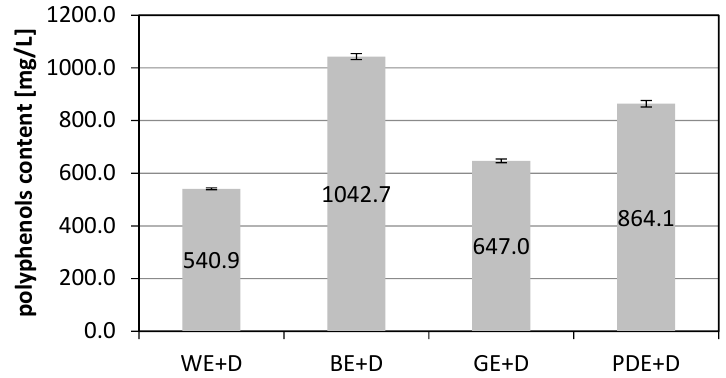
Figure 1. Total content of polyphenols expressed as mg of Gallic acid equivalents (GA) in 1 L of dogwood extracts (WE+D—water extract, BE+D—water/betaine extract, GE+D—water/glycerin extract, PDE+D—water/propanediol extract) averaged from three measurements.